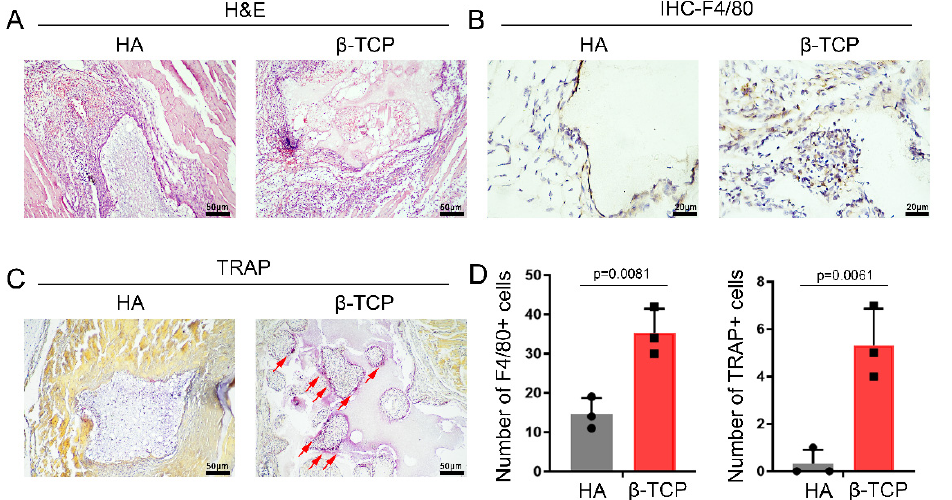
Figure 1. FBGC-mediated biodegradation of β -TCP is more pronounced than that of HA. ( A ) H and E staining showed the biodegradation of β -TCP and HA. ( B ) IHC staining of the macrophage’s marker F4/80. ( C ) TRAP staining showed the FBGCs marked by red arrows. ( D ) Semiquantitative comparison of positive expression. n = 3, black circles and blocks represent values from a single sample.